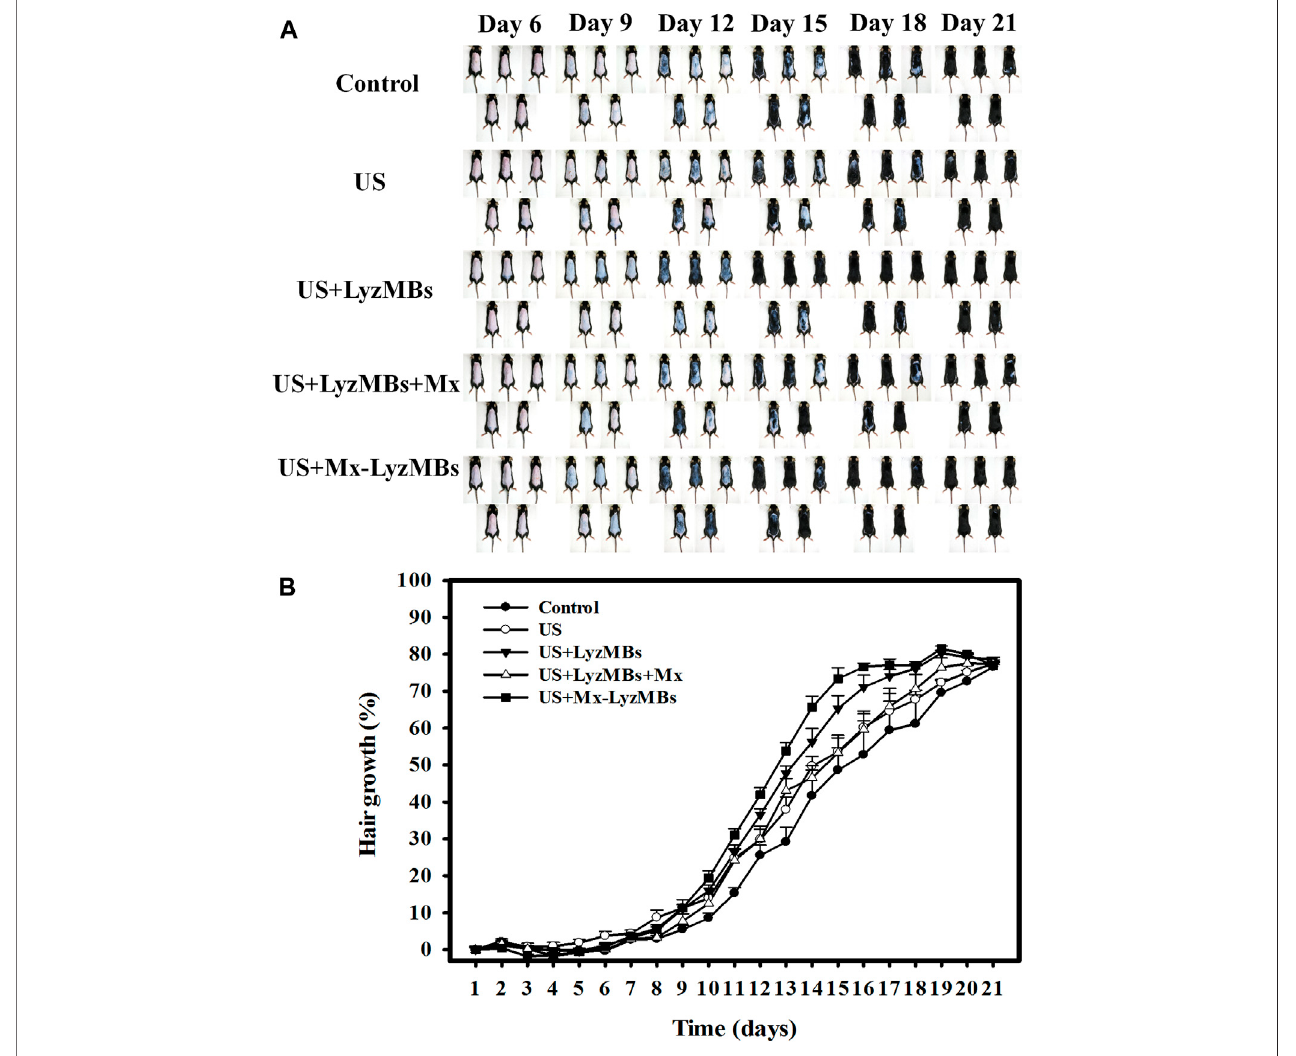
FIGURE 8 | (A) GrossobservationsofthedorsalskinofC57BL/6mice.Thedorsalskinsurfacesofthemicewereshaved,andthentestcompoundsandtreatmentswere topicallyappliedfor3 weeks. (B) Quanti fi cationofhairgrowthratesonthedorsalskinaftershavingthehairinvariousmousegroupsover21 days.DataaremeanandSEMvalues.